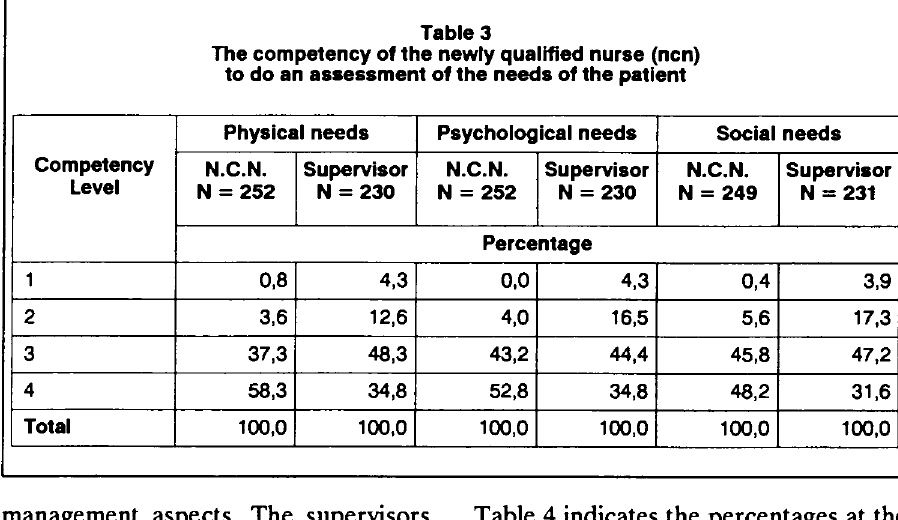
Table 4 Competency of the newly qualified nurse to work with